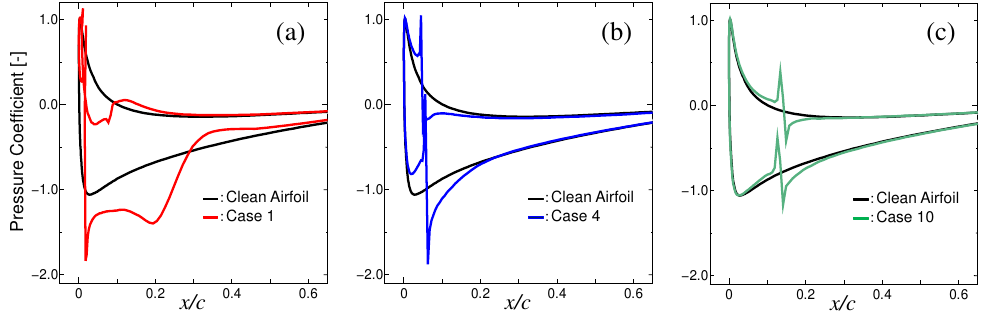
Figure 11. Distribution of pressure coefficient compared with that of clean airfoil without icing: ( a ) Case 1; ( b ) Case 4; ( c ) Case